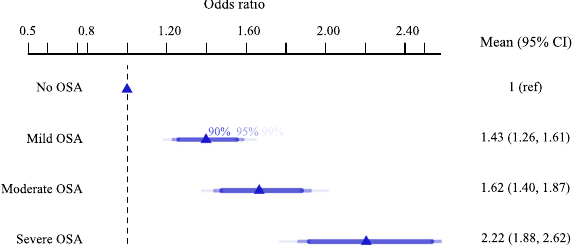
Fig. 3 Association between obstructive sleep apnea (OSA) severity with uncontrolled hypertension. Odds ratio (Estimate and 95% con fi dence interval) of the association between obstructive sleep apnea (OSA) severity with hypertension. This model is controlled for age, sex, and BMI. OSA category was de fi ned using standard clinical cut-offs of the apnea – hypopnoea index where <5 = no OSA, ≥ 5 and <15 = mild, ≥ 15 and <30 = moderate and ≥ 30 events/h sleep = severe OSA).